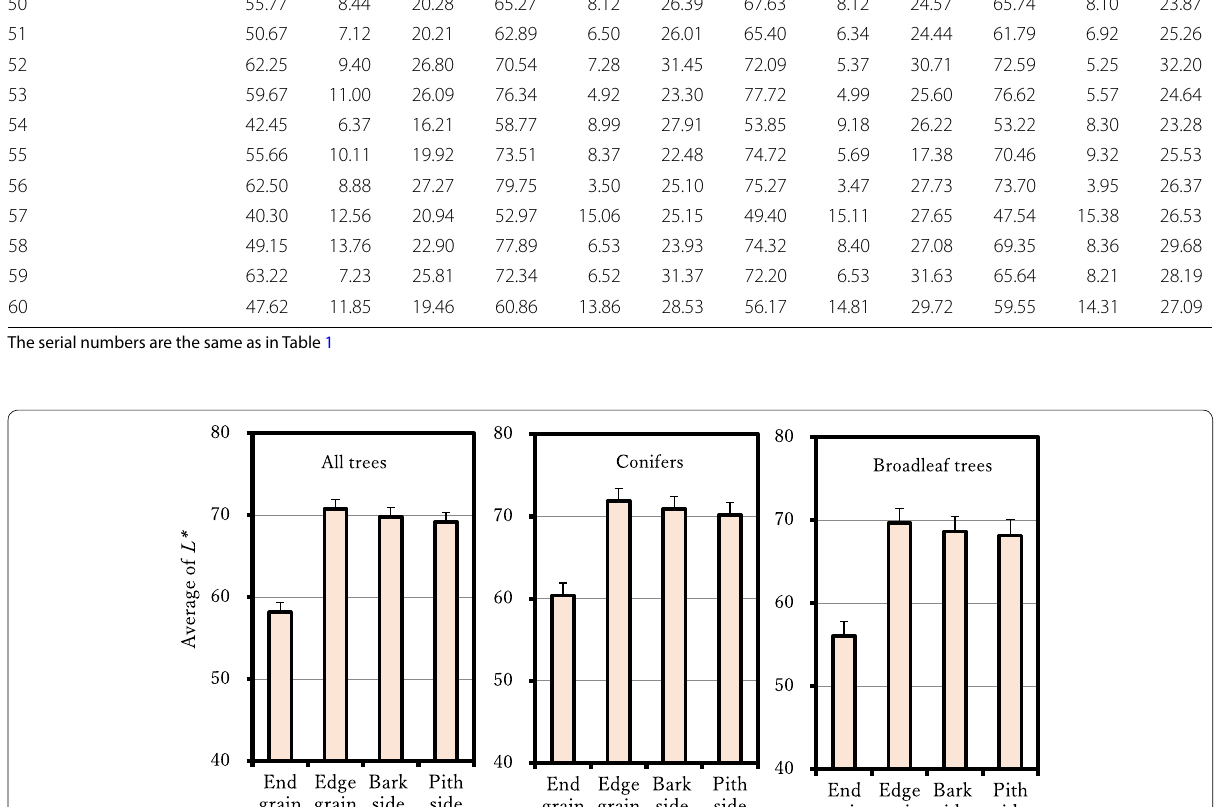
Table 6 shows the results of the paired t test of the differ- ences between the average values of each measurement plane for each C * and h shown in Fig. 6. According to Fig. 6 and Table 6, for all trees, both C * and h are the smallest on the end grain, and are almost the same values on the other planes. For both C * and h , there are significant differences between the end grain and each of the other planes. Therefore, it can be said that the end grain is a dull color with less vividness and a strong reddish color compared to other planes.